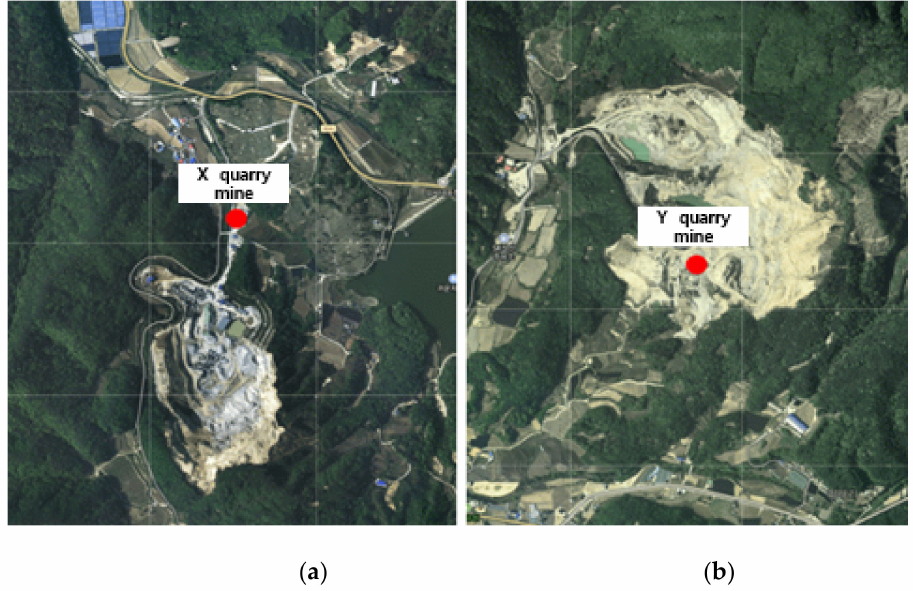
Figure 1. Location of the study sites. ( a ) X quarry; ( b ) Y quarry.